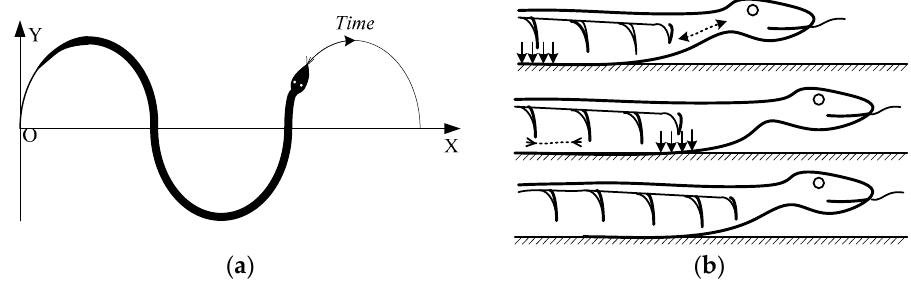
Figure 1. ( a ) Serpentine locomotion. ( b ) Rectilinear locomotion.